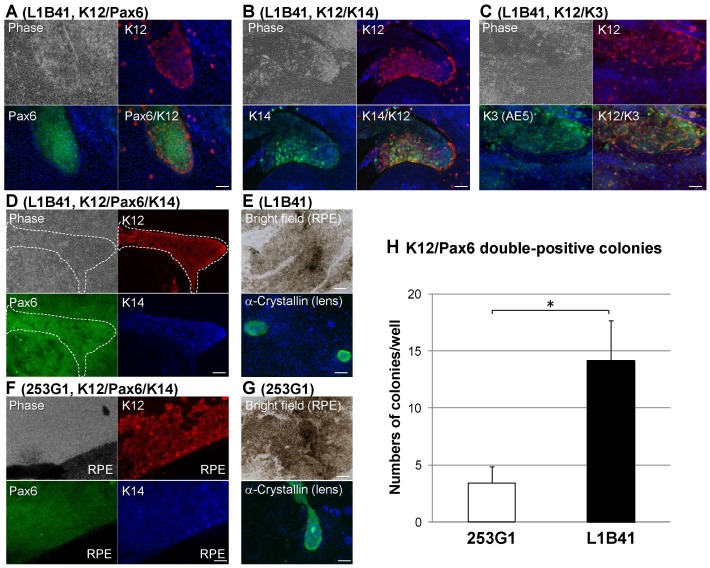
Immunofluorescence of corneal epithelial cell colonies induced from iPS cells.To examine corneal epithelial differentiation, double or triple immunostaining was performed. (A) Pax6 (green) and K12 (red) co-expressing colonies were observed in L1B41 cells differentiated for 12 weeks by the SDIA method. (B, C) Similarly, K12-expressing (red) colonies also co-expressed K14 and K3 (green) in L1B41 cells. (D) Furthermore, triple immunostaining showed that all 3 corneal epithelial differentiation markers co-localized in L1B41 (K12: red, Pax6: green, K14: blue). (F) Even in 253G1 iPS cells, corneal epithelial cell colonies were detected by immunostaining after approximately 15 weeks or later during the differentiation period (K12: red, Pax6: green, K14: blue). (E, G) The SDIA method was also able to induce RPE and lens epithelium (α-Crystallin+ cells) in both iPS cell lines. The number of corneal epithelial colonies (Pax6 and K12 double-positive) in L1B41 and 253G1 induced by SDIA method for 14 weeks were counted. (H) Corneal epithelial colonies in L1B41 were significantly higher than in 253G1. The graph showed the mean ± S.E. of 5 or 7 independent samples, respectively. Scale bar: 100 µm, *p<0.05 (t-test).